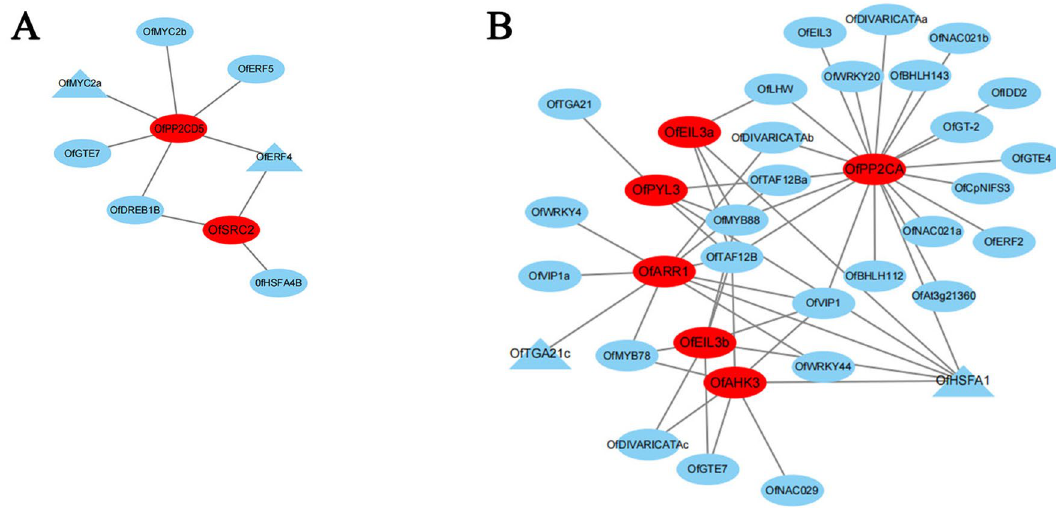
Figure 5. Regulatory networks of hub genes and edge genes in feature modules. ( A ) Construction of a regulatory network of JA-related upregulated genes and transcription factors in ‘royalblue’ module. ( B ) Construction of a regulatory network of IAA-related upregulated genes and transcription factors in the ‘brown’ module. Hub genes are red ellipses, transcription factors are blue ellipses, and TFs with the highest correlation are blue